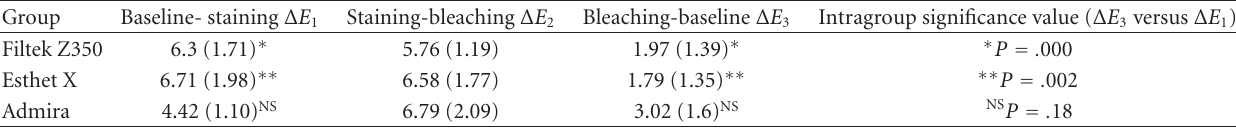
Table 2: Total discoloration ( Δ E ) for all test samples at three di ff erent time intervals using one way ANOVA and multiple comparison test of total discoloration ( Δ E ) between di ff erent test materials using Bon Ferroni correction.